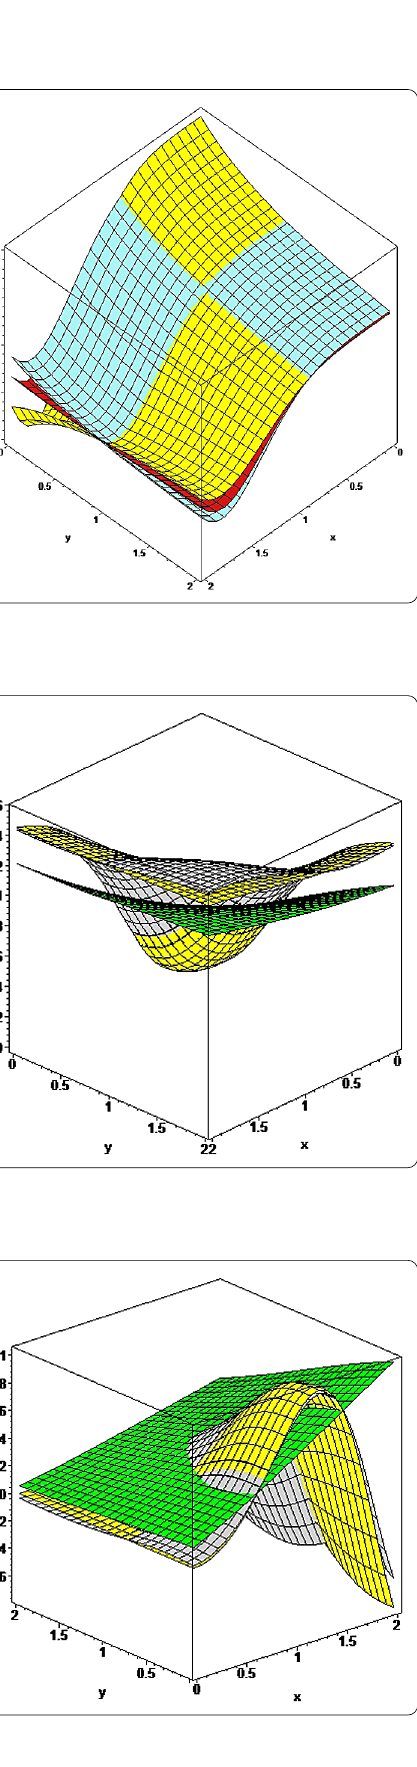
Figure 5 Convergence of T ( α 1, α 2, β 1, β 2) n 1, n 2, p 1, p y ) to f ( x , y ).